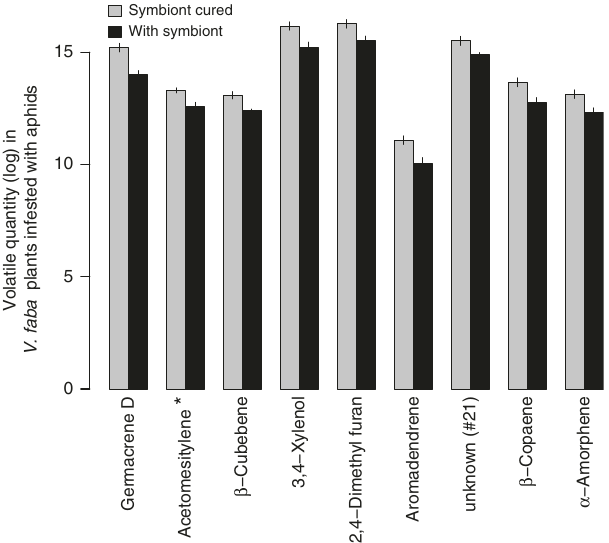
Fig. 4 Quanti fi cation of selected volatile compounds found in the plant headspace. Volatiles were collected from Vicia faba plants infested with Acyrthosiphon pisum aphids carrying the symbiont Hamiltonella defensa , or not. Values are expressed as peak areas divided by dry plant weight (g) and the bars show standard errors. As shown in Supplementary Table 2, pairwise comparisons were performed for those compounds with a ‘ variable importance in projection ’ (VIP) score larger than one in the Principal least squares discriminant analysis (PLS-DA). Only compounds whose quantity was signi fi cantly different after correcting p -values with the false discovery rate approach are included. *Acetomesitylene: